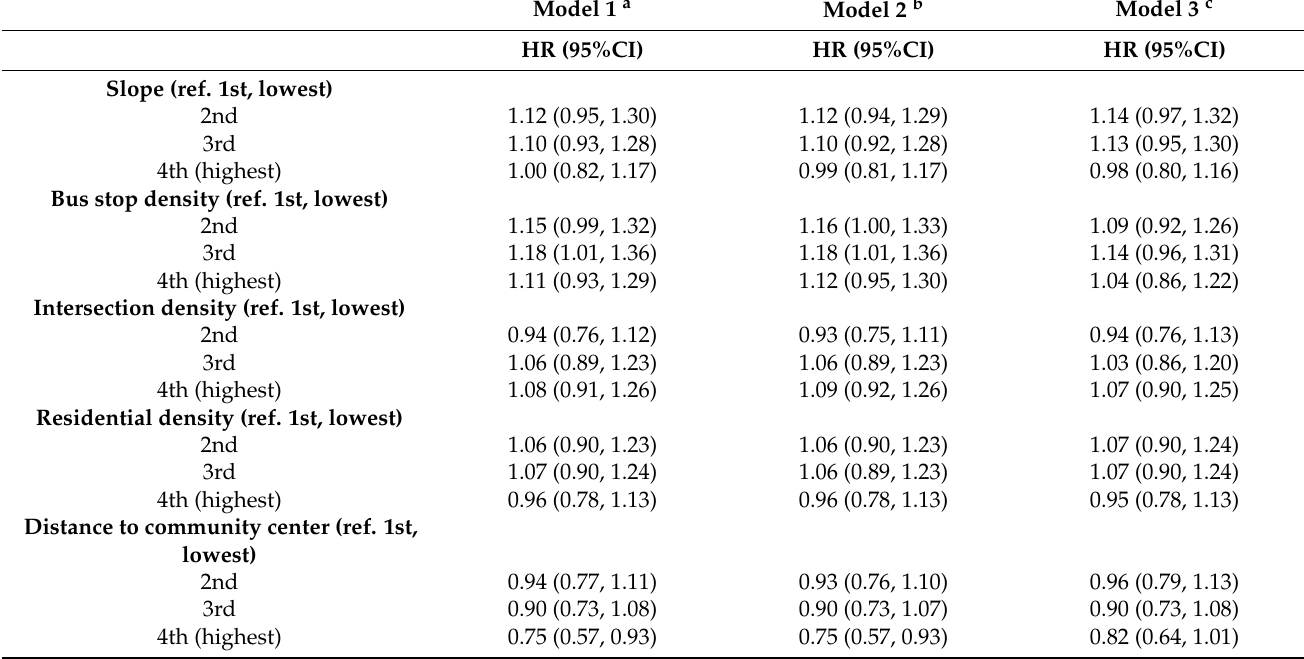
Table 3. Cox proportional hazard model for physical inactivity by neighborhood environmental